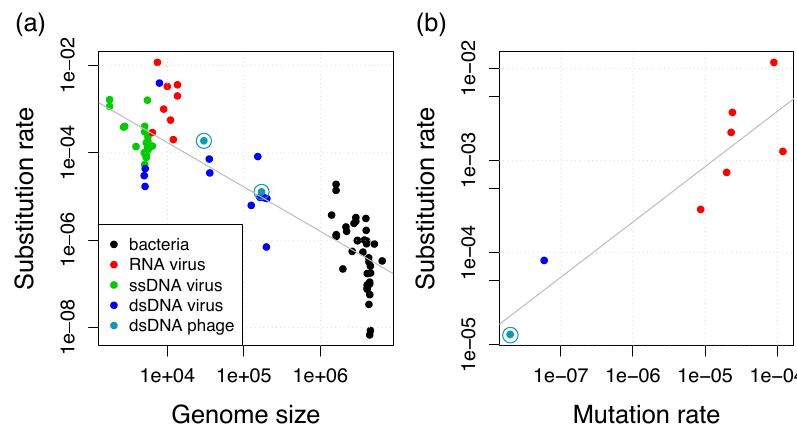
Figure 5. ( a ) Negative relationship between substitution rate and genome size for viruses and bacteria. Additional data points from the collections in References [17,48] and additional estimates from Reference [46] if they are also in ( b ); ( b ) Positive relationship between substitution rate and mutation rate for viruses. Additional data points from References [13,46]. Gray lines show the linear regressions.